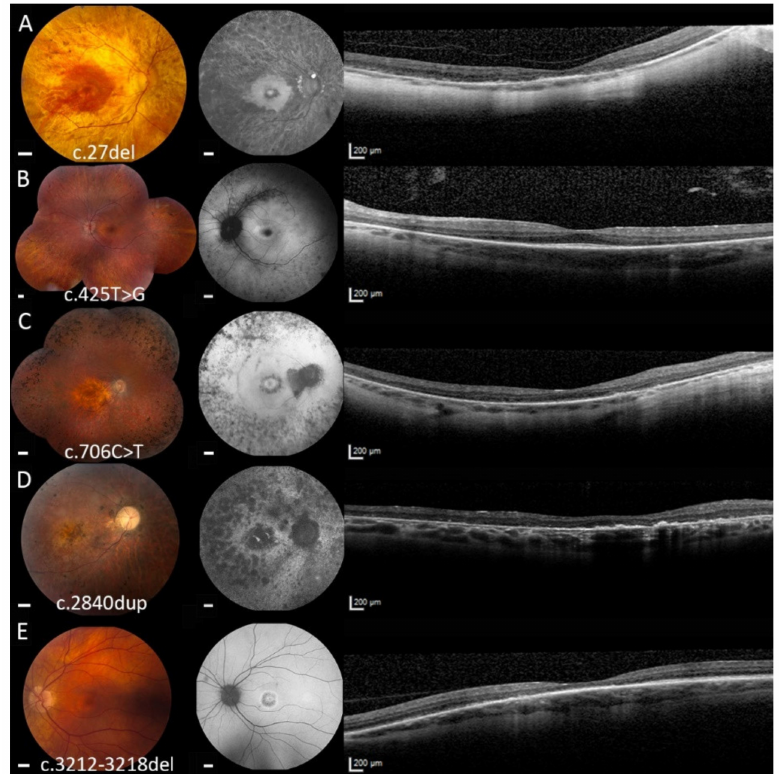
Figure2. Colorfundusphotographs(scalebar = 1mm)andcorrespondingfundusautofluorescence(FAF, scale bar = 1 mm) and spectral-domain optical coherence tomography (SD-OCT, scale bar = 200 µ m) images of patients carrying mutations in the RPGR gene. ( A ) The right eye of patient A-1, with a best-corrected visual acuity (BCVA) of 0.05, showing a tilted optic disc, vascular attenuation, and bone-spicule hyperpigmentation in the midperiphery. Degenerative changes are seen across the entire retina, with sparing of the central macula. An atrophic perifoveal ring is present, resembling a bull’s eye maculopathy. Correspondingly, FAF imaging in this patient showed hypo-autofluorescent (hypo-AF) lesions throughout the posterior pole, with sparing of the central macula, and some optic disc drusen. On SD-OCT imaging, atrophy of outer retinal layers is observed, with some relative preservation of the ellipsoid zone (EZ) at the fovea. ( B ) The composite fundus photograph of the left eye of patient B-2 (BCVA of 0.9), showing optic nerve head drusen, normal vessels, and bone-spicule hyperpigmentation in the periphery. FAF imaging showed hypo-AF regions along the vascular arcades and far periphery. A macular hyperautofluorescent (hyper-AF) ring is observed, which matches the extent of EZ loss seen on SD-OCT. ( C ) The right eye of patient C-4 (BCVA of 0.36) carrying the c.706C > T (p.[Gln236*]) mutation. In addition to bone-spicule hyperpigmentation in the periphery, the fundus of this patient also displayed atrophic changes in the macula. A hyper-AF ring was seen on FAF, encircled by a hypo-AF ring, which corresponded with the loss of outer retinal bands on SD-OCT. ( D ) The right eye of patient G-8, with a BCVA of 0.25. The accumulation of hyperpigmented clumps in the macular region is observed, as well as outside the retinal vascular arcades. On FAF imaging, granular hypo-AF lesions are seen in the posterior pole, and a large central hypo-AF area is seen. SD-OCT imaging shows atrophy of retinal layers, with increased choroidal visibility. Remnants of the outer retinal bands are present in the (para)fovea, together with hyperreflective elevations at the level of the retinal pigment epithelium (RPE) that seem to correspond to the hyperpigmented deposits on fundus photography. ( E ) The left eye of patient H-9 (BCVA of 0.76), with a cone-rod dystrophy phenotype. A bull’s eye appearance is seen in the macula on fundus examination, without the presence of bone-spicule-like deposits. Similar findings are seen on FAF imaging, with hyper-AF spot in the fovea, where the outer retinal layers are relatively preserved on SD-OCT, surrounded by a hypo-AF ring of outer retinal and RPE atrophy, which itself is surrounded by a hyper-AF